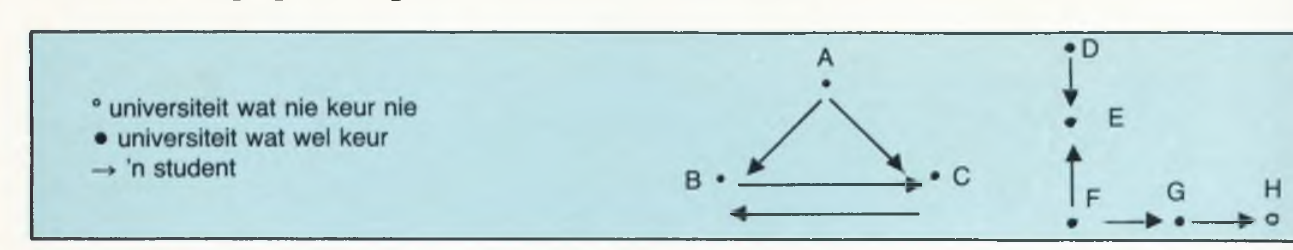
Slegs 34 uit die 48 studente